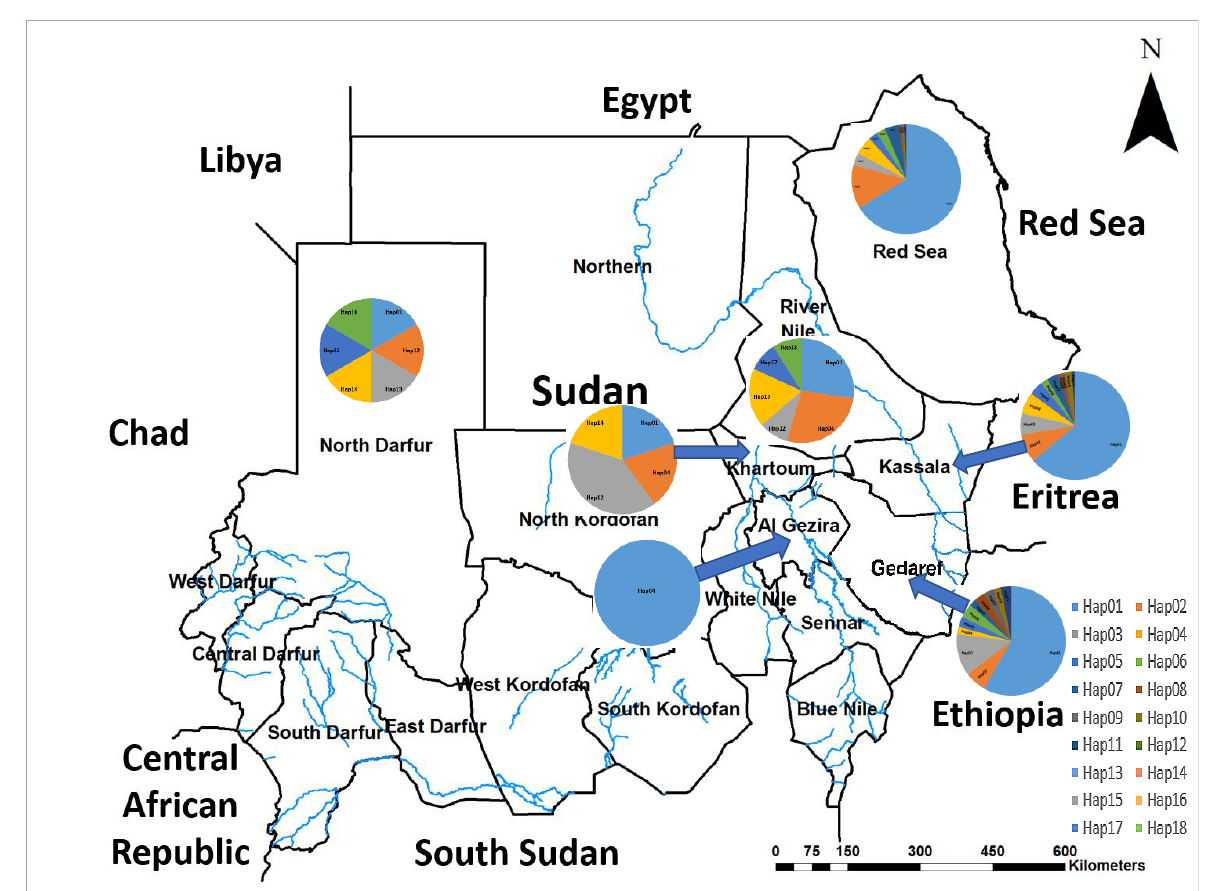
Figure 6. Pie charts inserted to show the haplotypic composition of An. stephensi population across the states of Sudan. Haplotypes of each region are presented in color code.